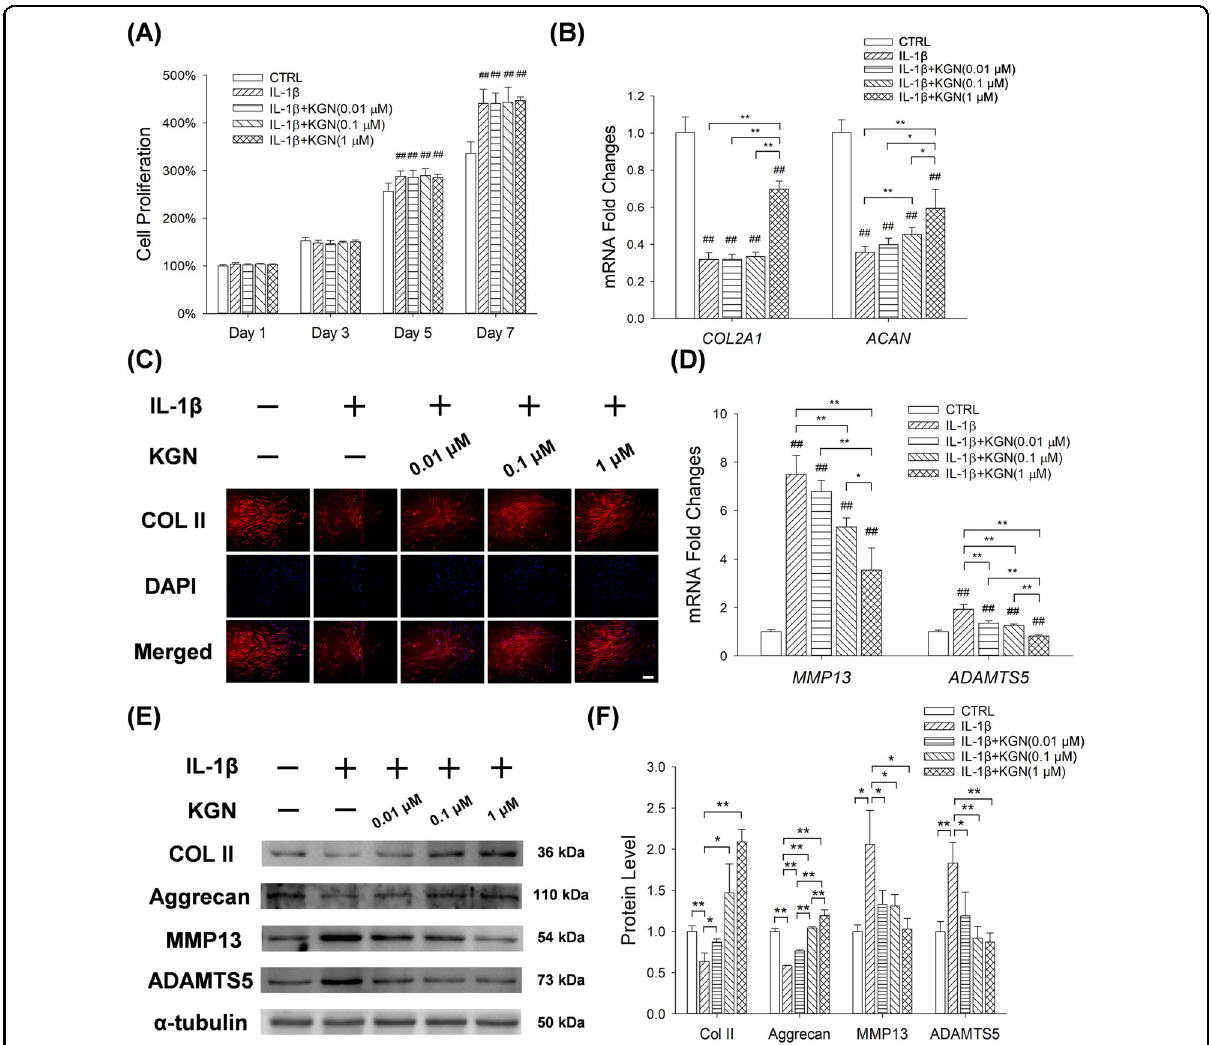
Fig. 2 Effect of KGN on the synthesis of chondrocyte matrix after IL-1 β treatment. A CCK-8 assay for the proliferation of chondrocytes 1, 3, 5 and 7 days after KGN treatment. B RT-PCR analysis for the expression levels of COL2A1 and ACAN mRNA in chondrocytes after KGN treatment. C Immuno fl uorescence analysis for the expression of COL II proteins in chondrocytes after KGN treatment. (Scale bar = 100 μ m). D RT-PCR for the expression levels of MMP13 and ADAMTS5 mRNA in chondrocytes after KGN treatment. E , F Western blot analysis for the expression of COL II, aggrecan, MMP13 and ADAMTS5 proteins in chondrocytes after KGN treatment. Values represent mean ± S.E.M of six replicas for cell proliferation assays, four replicas for RT-PCR experiments and three replicas for Western blot assays, respectively. (* p < 0.05 and ** p < 0.01; between the indicated groups and # p < 0.05 or ## p < 0 . 01 versus the CTRL